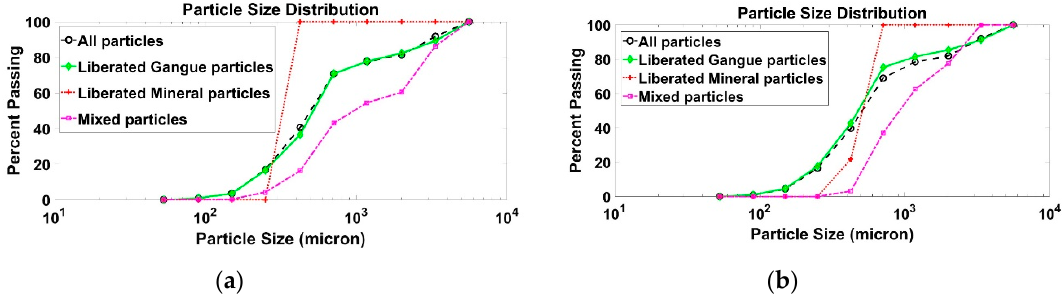
Figure 3. ( a ) PSD of produced particles in random breakage of ore of Figure 2; ( b ) PSD of produced particles in preferential breakage of ore of Figure 2.